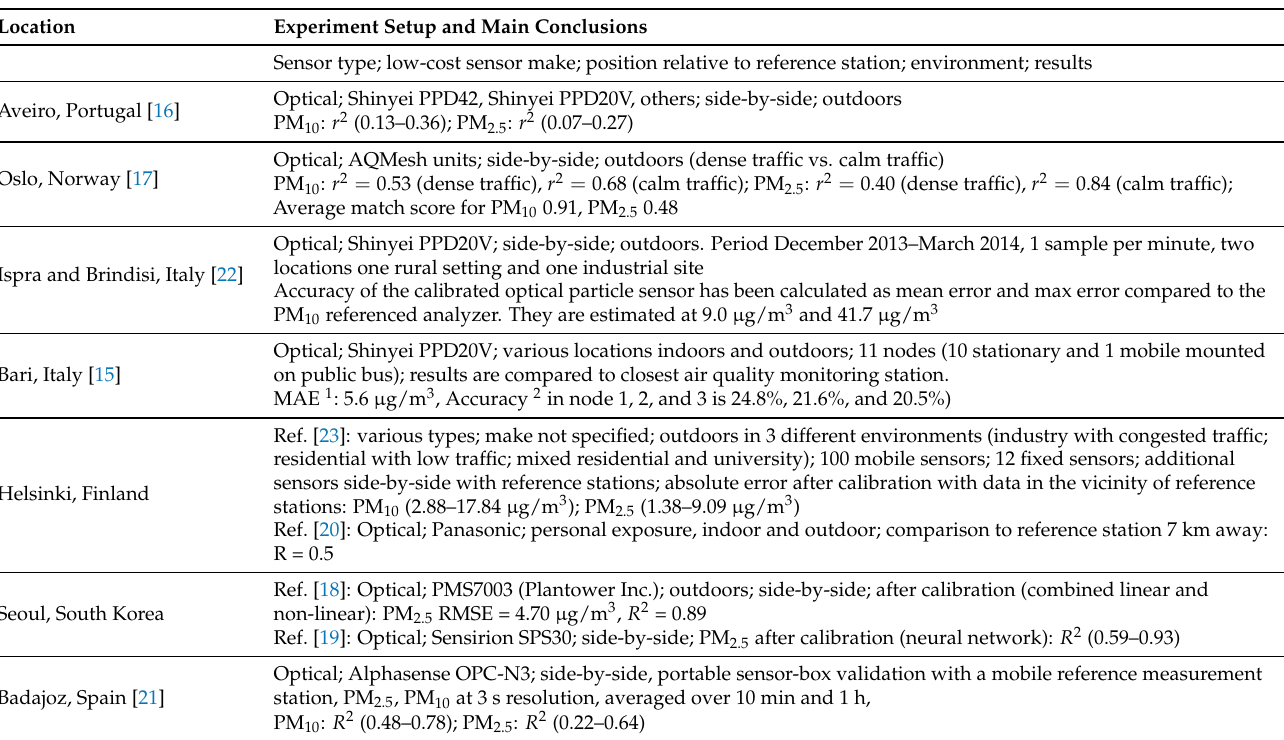
Table 1. Overview of experiments and field tests comparing particulate matter measurements from low-cost sensors to reference